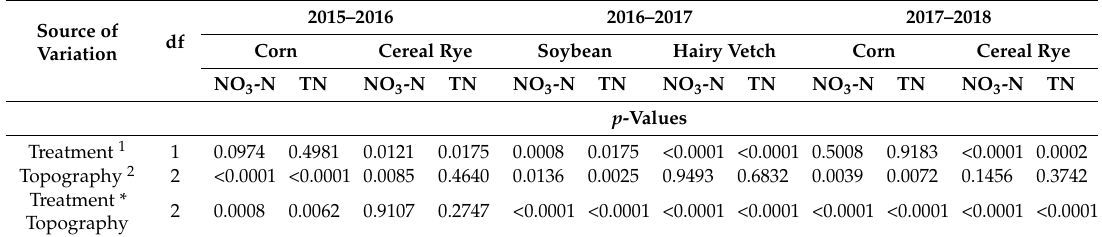
Table 4. Probability values ( p -values) and numerator degrees of freedom (df) associated with the sources of variation in the statistical analysis for soil solution nitrate-N (NO 3 -N) and total N (TN) concentrations that were collected with a tension cup